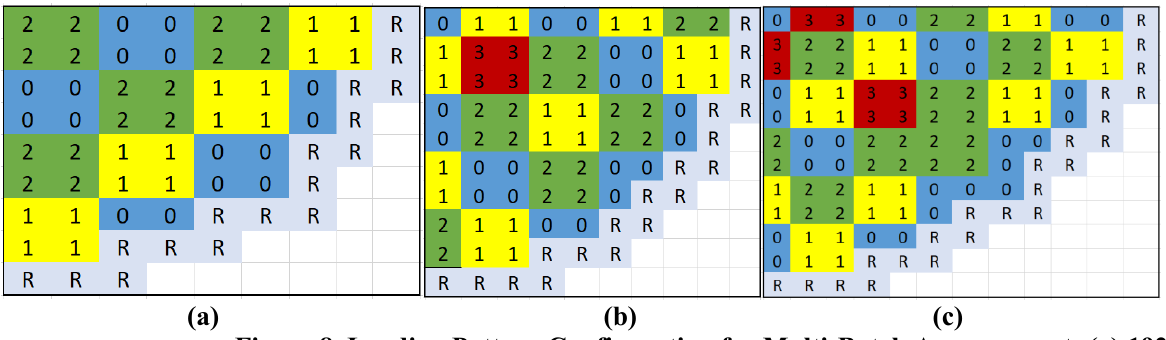
Figure 8. Loading Pattern Configuration for Multi-Batch Arrangement: (a) 192